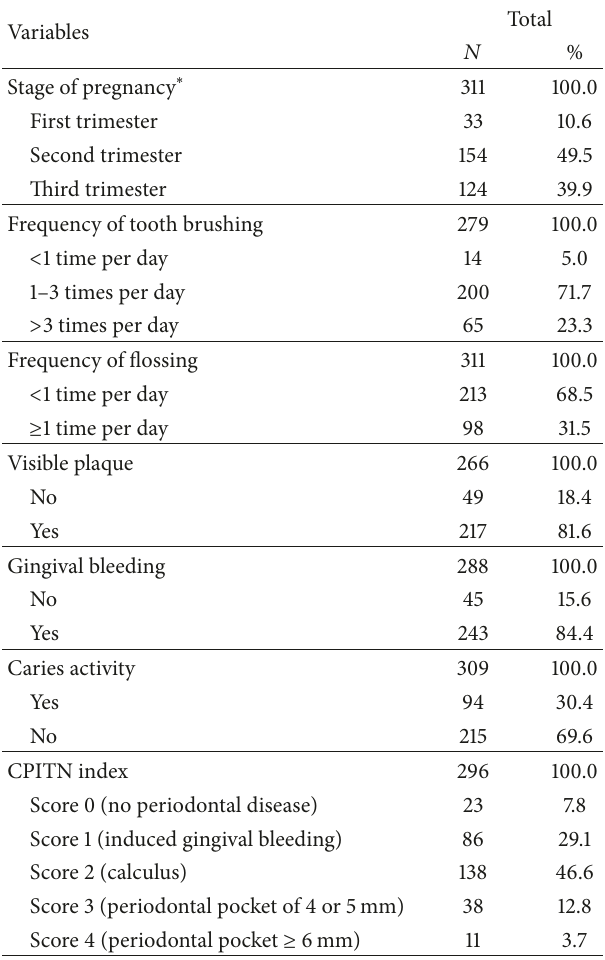
Table 2: Clinical variables related to pregnancy ( 𝑛 = 311